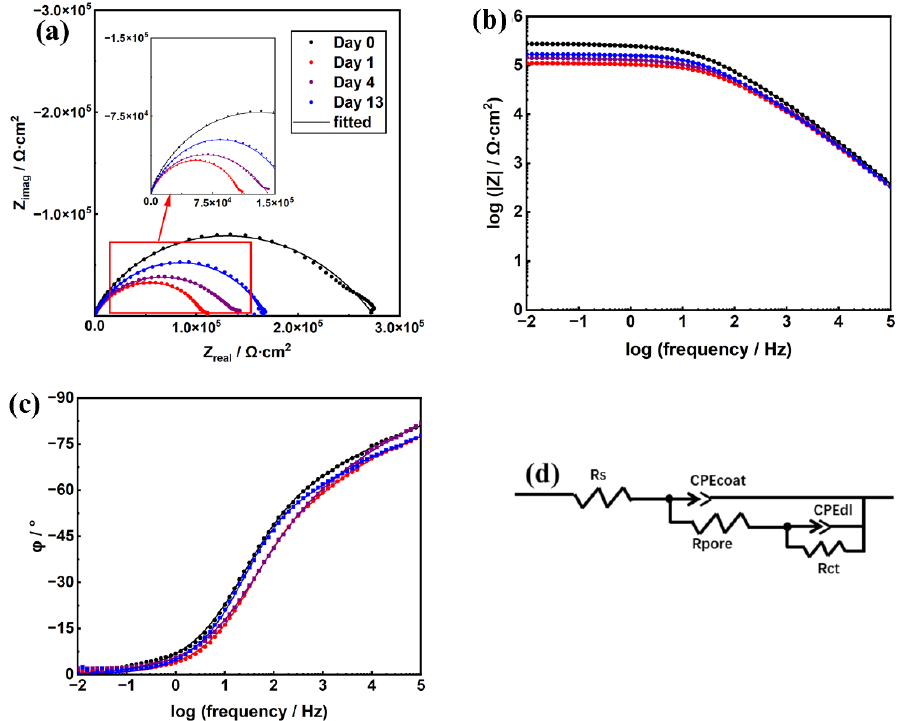
Figure 8. EIS spectra ( a – c ) and EECs for the data fitting ( d ) of 2CB-67Zn on days 0, 1, 4 and 13. Table 3. Fitted CPE coat , R pore, CPE dl and R ct values of 2CB-67Zn.